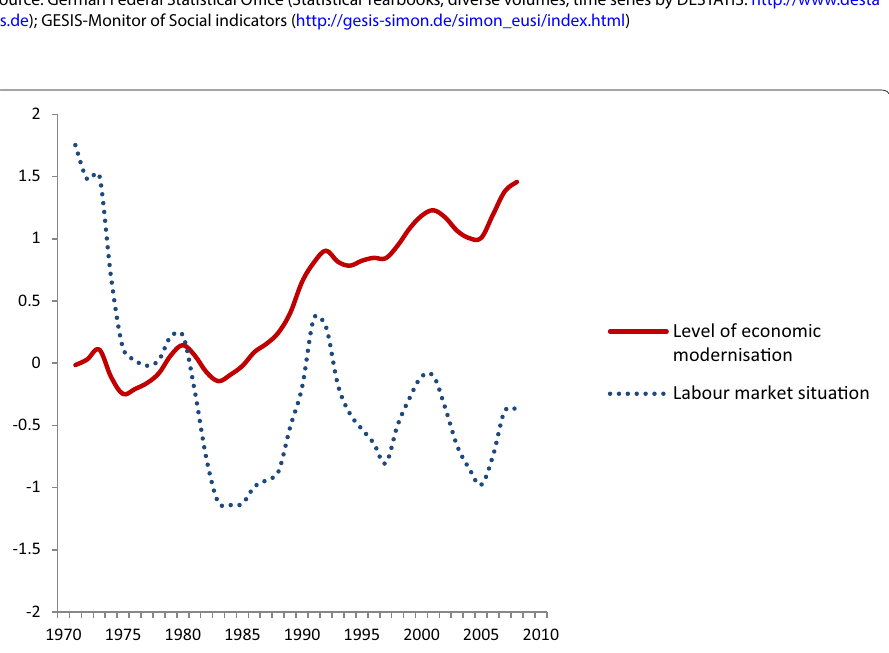
Fig. 1 Trend of economic modernisation and change of labour market situation in West